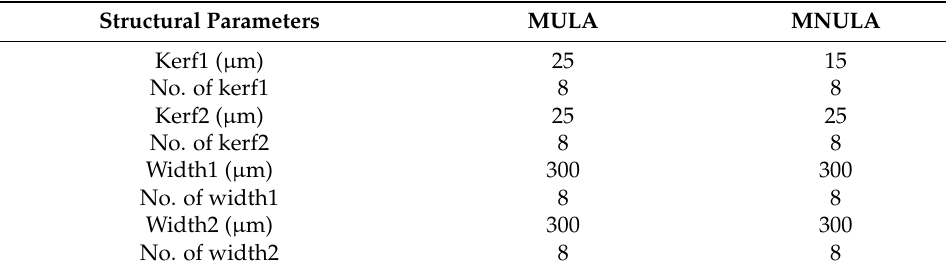
Figure 13. The linear array transducers made by a lab. ( a ) An MNULA and ( b ) an MULA. In order to ensure that only the structural parameters of the transducer affected the final imaging results, the performance of the elements of the uniform MULAs and MNU- LAs was tested and carefully compared to make sure that manufacturing process was kept consistent when making different MULAs. In this way, the quality of the transducers was kept consistent. The amplitude and frequency distribution of the elements in the uniform part are shown in Figure 14. For peak-to-peak voltage, the difference between the MULA and the MNULA was around 400 mV. The center frequency values remained at an average of 13.5 MHz. For bandwidth, the MULA remain had an average of 35% and the MNULA had an average of 40%. We think this was a tolerable difference between the different arrays. For the MULA and the MNULA, different elements kept a strong consistency in peak-to-peak voltage, center frequency, and bandwidth. It can be concluded that an MULA and an